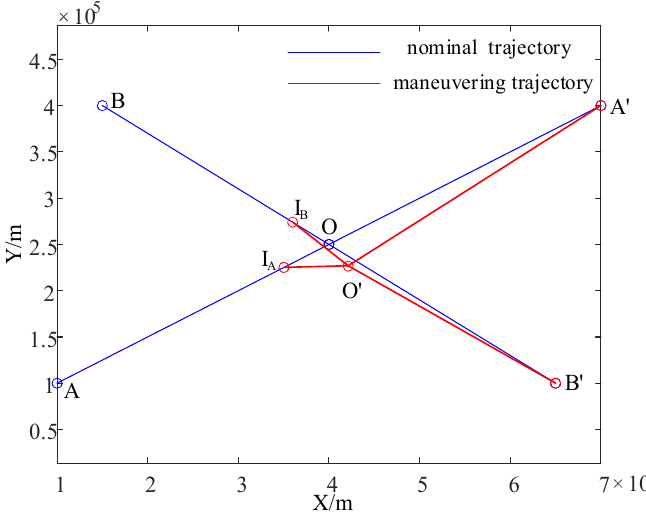
Figure 10. Trajectory diagram of maneuver separation assurance strategy at priority 1:2. Table 4. Simulation results at different priorities.